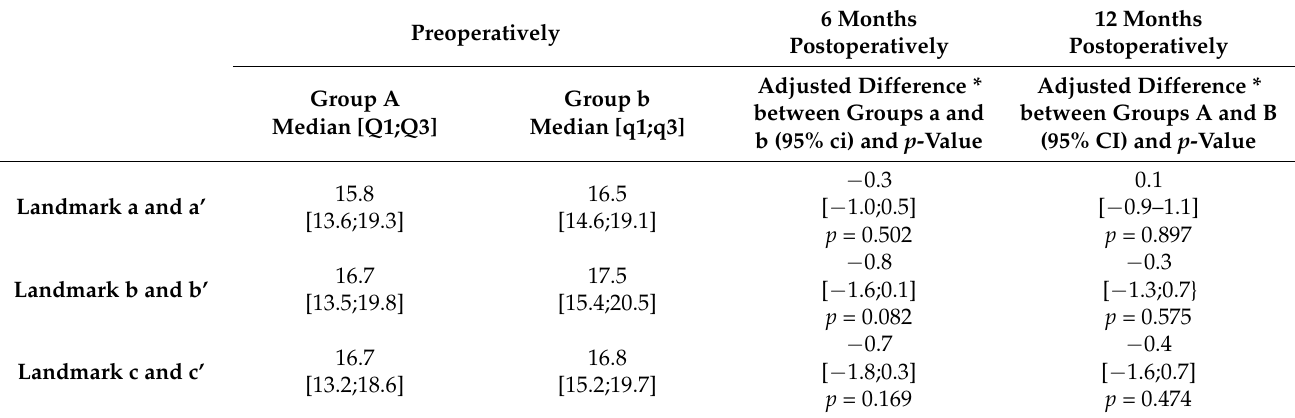
Table 3. Eyebrow height in millimetres (median[Q1;Q3]): differences between